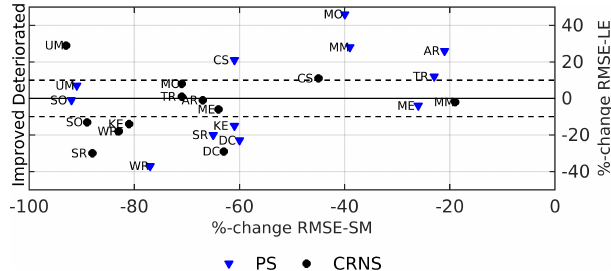
Figure 6. Relative change in RMSE values after single-objective calibration against PS soil moisture and CRNS neutron count data. Change in RMSE between observed and simulated latent heat flux (LE) is plotted against change in RMSE between observed and sim- ulated soil